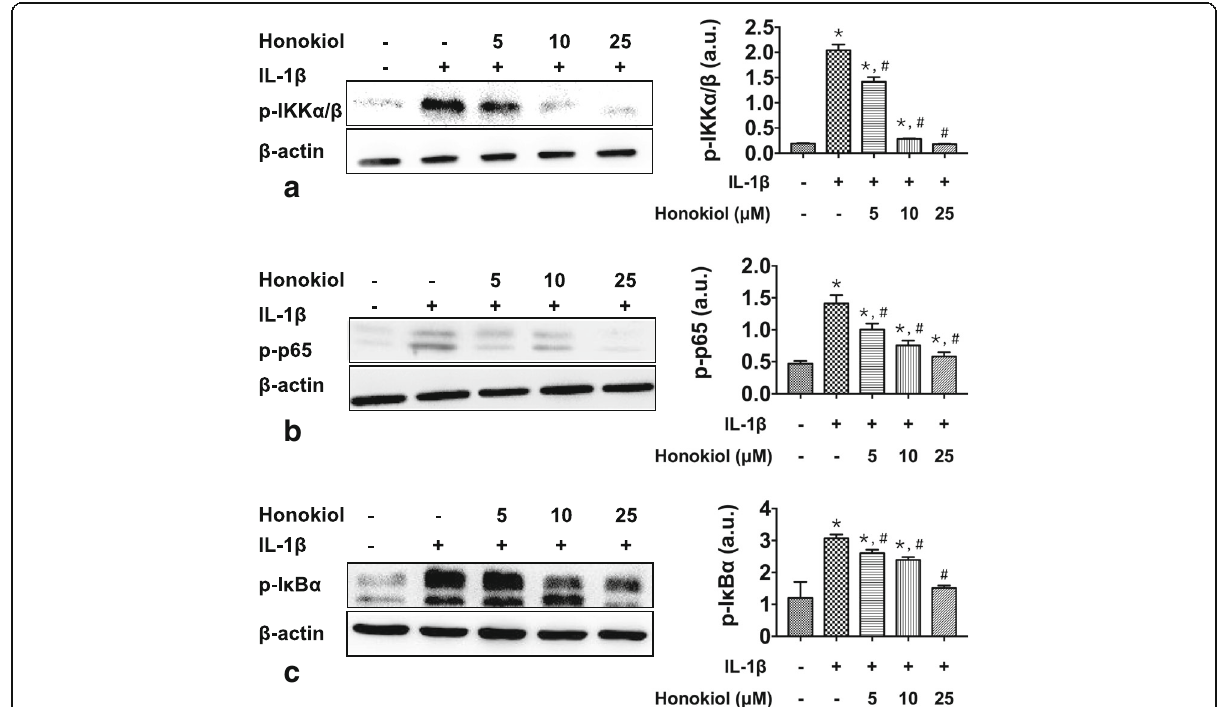
Fig. 7 Honokiol inhibited NF- κ B pathway in hUC-MSCs in a dose-dependent manner. 2nd passage hUC-MSCs were cultured in pellets with chondrogenic medium, cells were treated with IL-1 β (0 or 10 ng/ml) and honokiol (0, 5, 10, 25 μ M). After 2 weeks, the expression of ( a ): p-IKK α / β , ( b ): p-p65, (c): p-I κ B α were evaluated by western blot. Integrated density values were analyzed by ImageJ and normalized to β -actin, all results were presented as mean ± SD ( n = 9); p * < 0.01 versus control; p # < 0.01 versus IL-1 β alone (10 ng/ml IL-1 β without